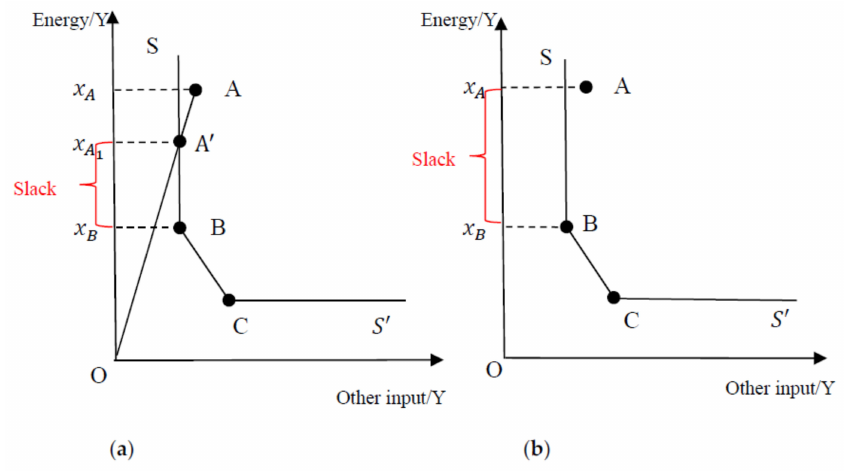
Figure 8. Slack of traditional DEA model ( a ) and SBM model ( b